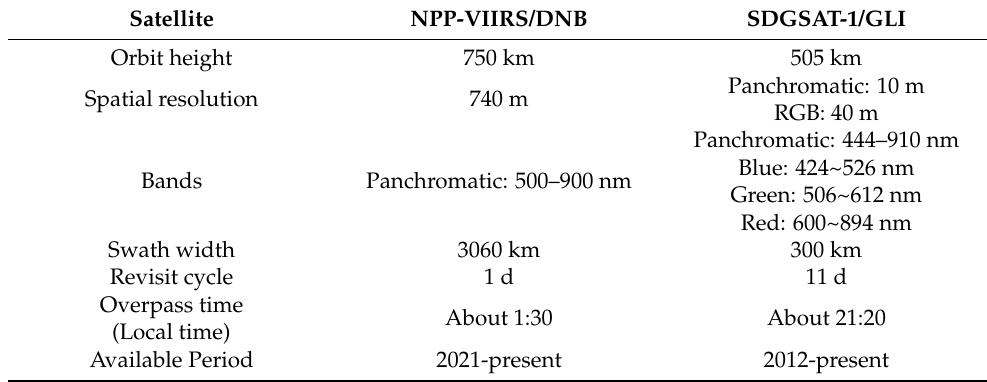
Table 2. The difference of night light images from VIIRS/DNB and SDGSAT-1/GLI.